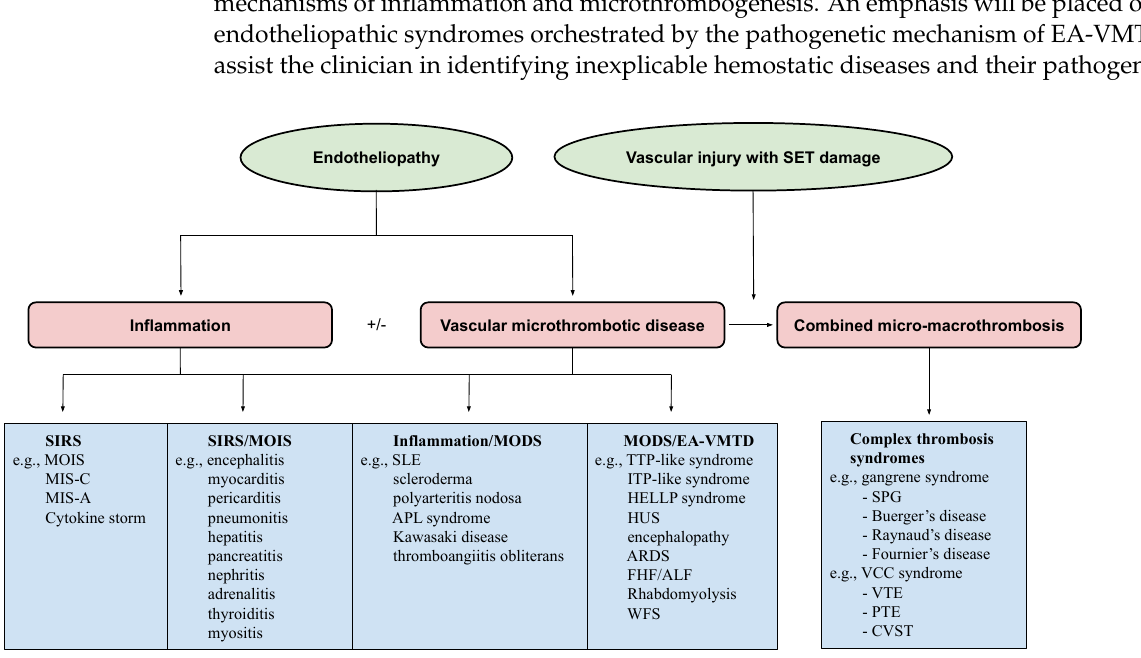
Figure 4. Projected spectrum of endotheliopathic syndromes in relation to endothelial pathogenesis and hemostasis. The illustrated figure shows that endotheliopathy is the underlying pathology of many human diseases, from inflammatory syndromes to vascular microthrombotic disease and combined micro–macrothrombosis, and it is manifested as many diseases on a spectrum. Because the roles of the endothelium and the contribution of the molecular mechanism of endotheliopathy as a hemostatic disease have not been clearly identified, the pathogenetic mechanisms of large parts of the endotheliopathic syndromes in this figure and the text have been considered to be mostly “unknown” or “idiopathic”. However, during the recent COVID-19 pandemic, the pathogenesis of ARDS was unmasked and confirmed to be the result of endotheliopathy leading to VMTD in COVID-19 sepsis. It was finally affirmed that endotheliopahy promotes a hemostatic disease via the lone activation of the ULVWF path of hemostasis as previously proposed [6,7]. Abbreviations: ALF: acute liver failure; APLA syndrome: antiphospholipid antibody syndrome; ARDS: acute respiratory